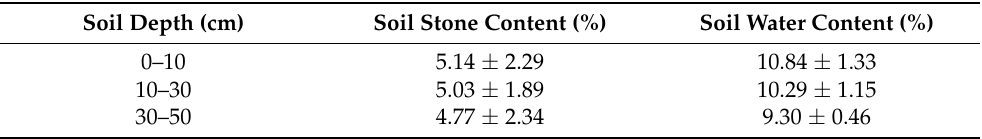
Table 2. Soil stone content and soil water content at different soil depths. Soil Depth (cm) Soil Stone Content